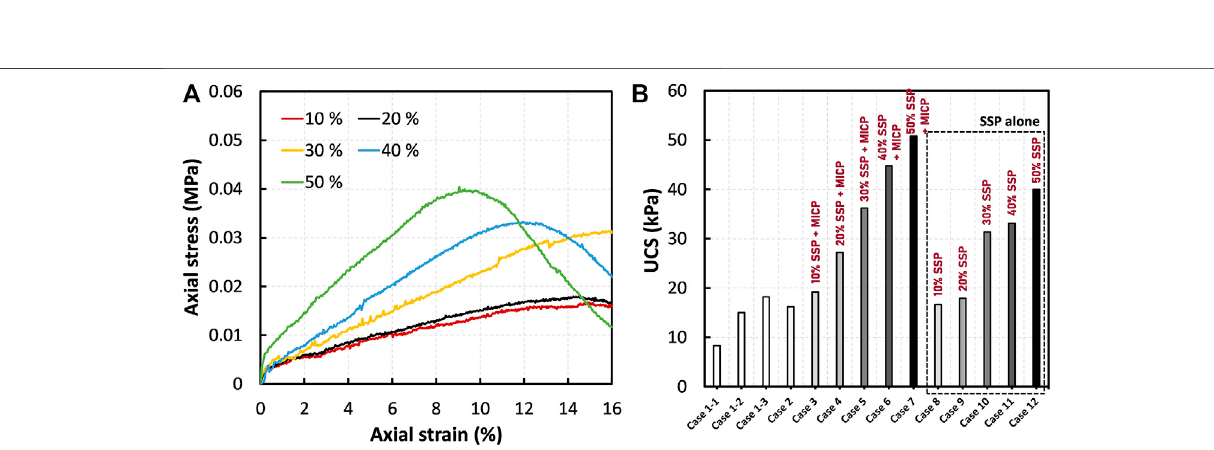
FIGURE 4 | (A) Effect of SSP on the stress – strain responses of the MICP-treated peat under compression: comparison between the cases 2 – 7, and (B) comparison of UCS together with control cases.